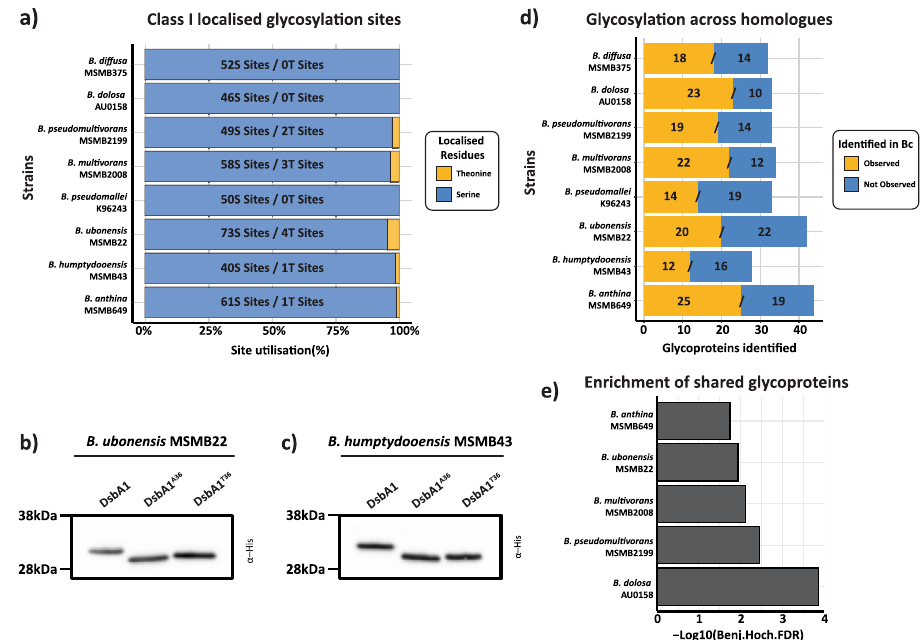
Fig. 5 Serine glycosylation and the conservation of glycoproteins across Burkholderia species. a The re-analysis of Burkholderia glycopeptide enrichment datasets reveals the majority of assigned glycosylation sites are localised to Serine residues. b , c Western analysis of DsbA1 Nm -his 6 variants expressed within B. ubonensis MSMB22 ( b ) and B. humptydooensis MSMB43 ( c ) supports that Threonine is disfavoured for glycosylation similar to B. cenocepacia . d Analysis of glycoproteins observed across Burkholderia species supports multiple B. cenocepacia glycoprotein homologues are observed glycosylated within other species. e Enrichment analysis of glycoproteins shows an enrichment of shared glycoproteins in B. anthina MSMB649; B. ubonensis MSMB22; B. multivorans MSMB2008; B. pseudomultivorans MSMB2199 and B. dolosa AU0158 compared to B. cenocepacia